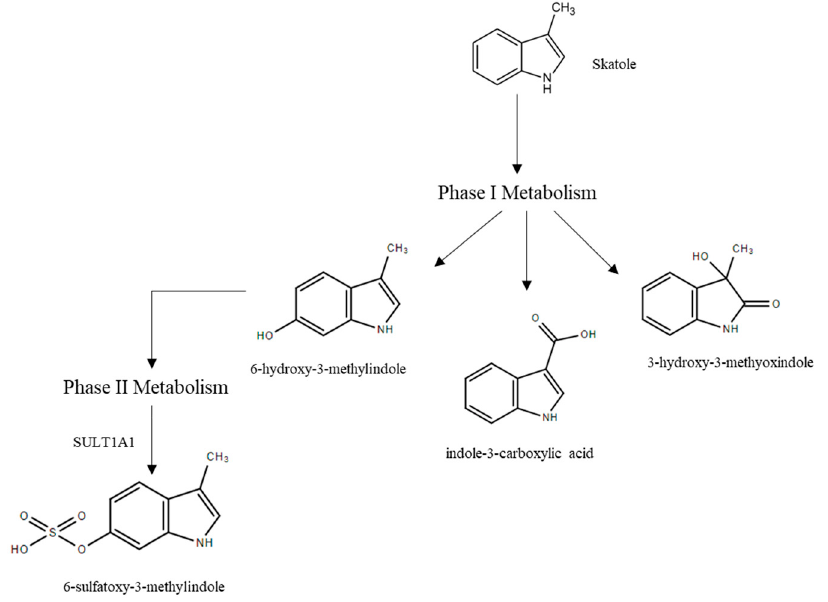
Figure 5. Pathways of skatole metabolism.